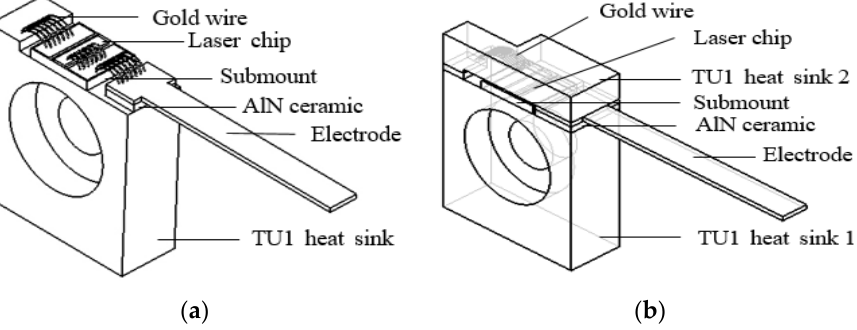
Figure 1. C-type and DC-type package structure diagrams. ( a ) C-type package structure and ( b ) DC- type package structure.